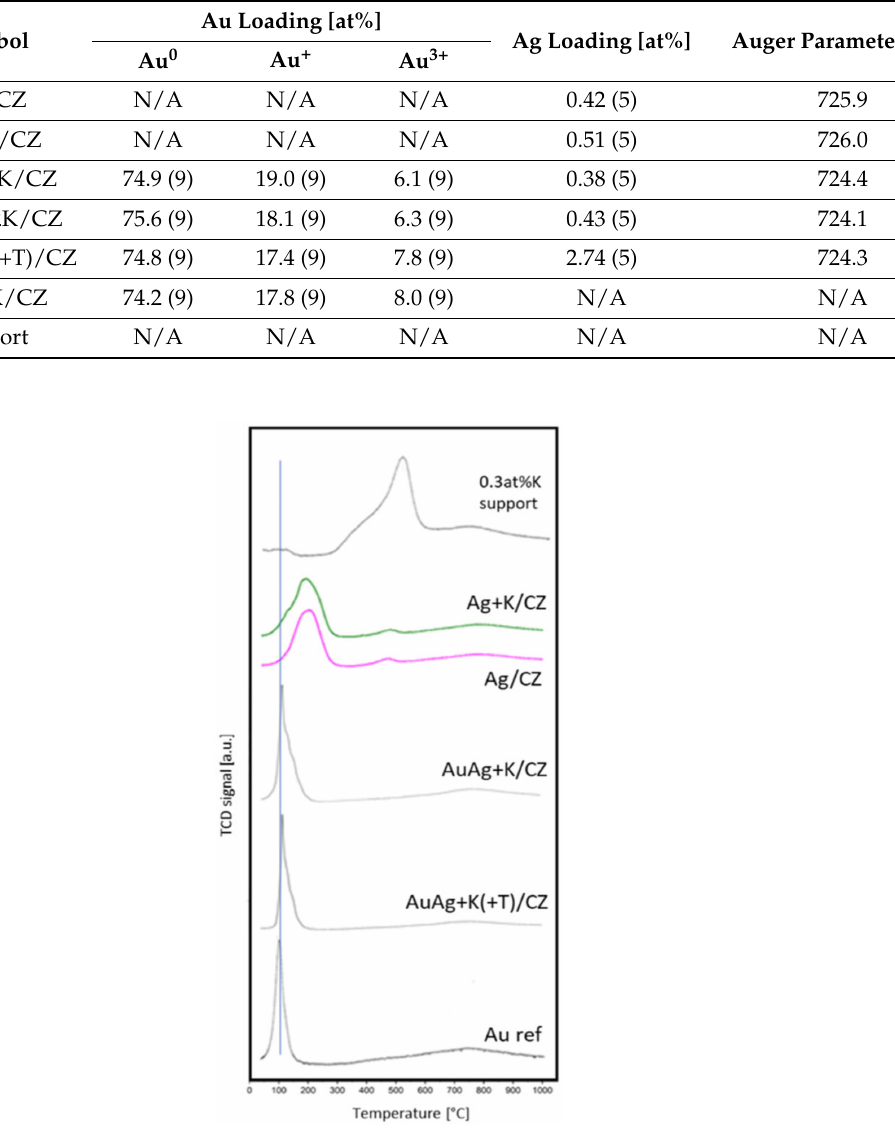
Figure 6. TPR profiles of the support doped with 0.3 at% K, the studied catalysts and the Au reference. A similar curve, though with a slightly less symmetrical first reduction peak, but also containing a mid-temperature peak, is obtained when potassium ions are deposited onto the silver catalyst. The signals for the bimetallic systems are narrower, but the presence of Ag affected the shape of the high temperature shoulder of the reduction peak. The maximum of the reduction peak of the TPR curves of bimetallic catalysts is lower than